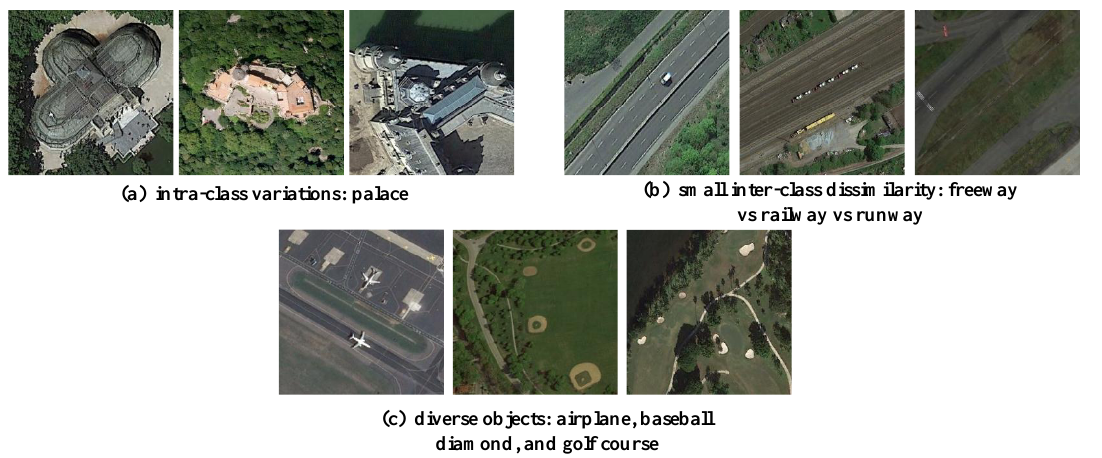
Figure 1. Three major challenges: ( a ) large intra-class variations; ( b ) small inter-class dissimilarity; ( c ) diverse objects in scene images. These examples come from the challenging NWPU-RESISC45 dataset [10].